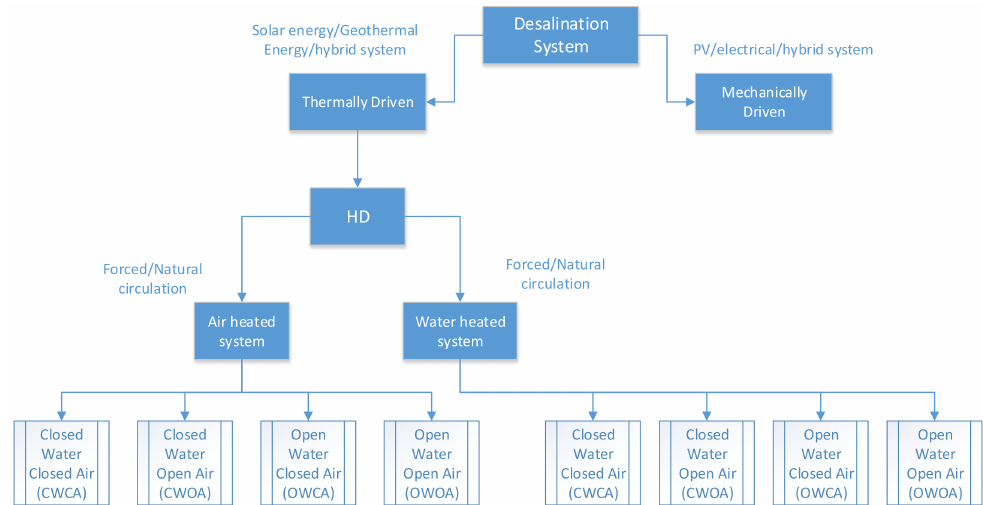
Figure 2. Classification of HD systems based on cycle configurations.